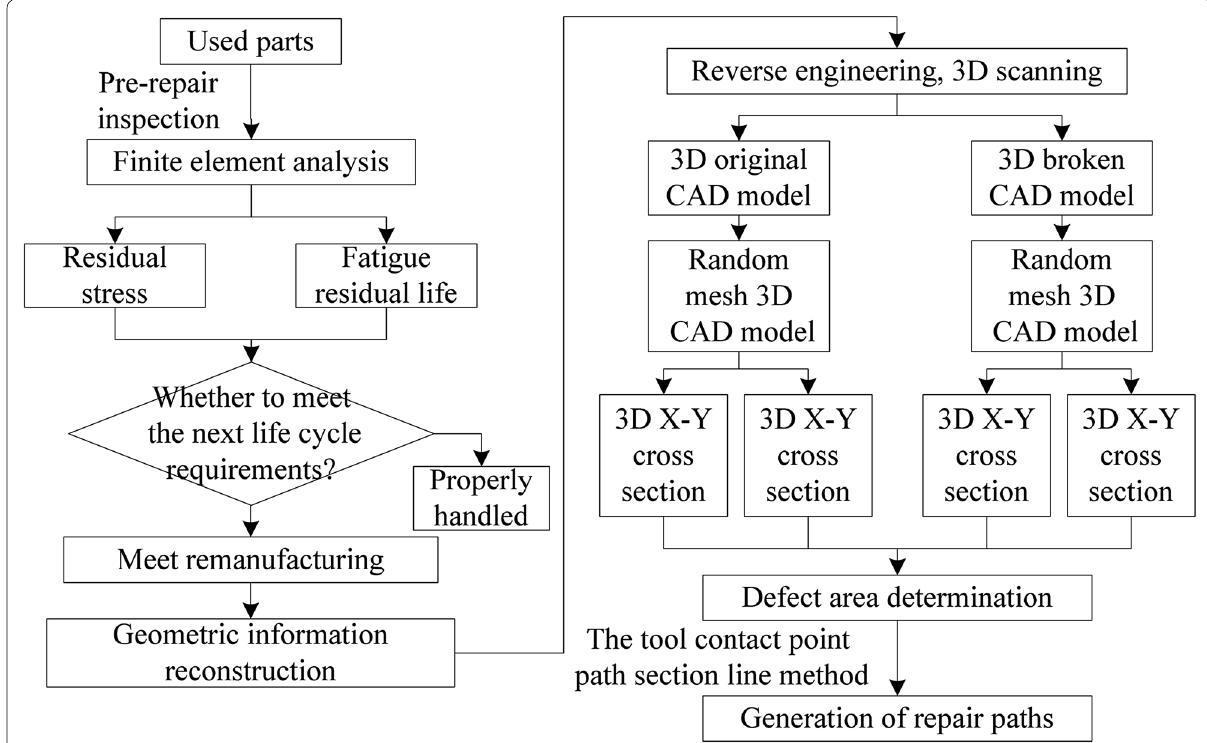
Figure 1 Remanufacturing design framework for used